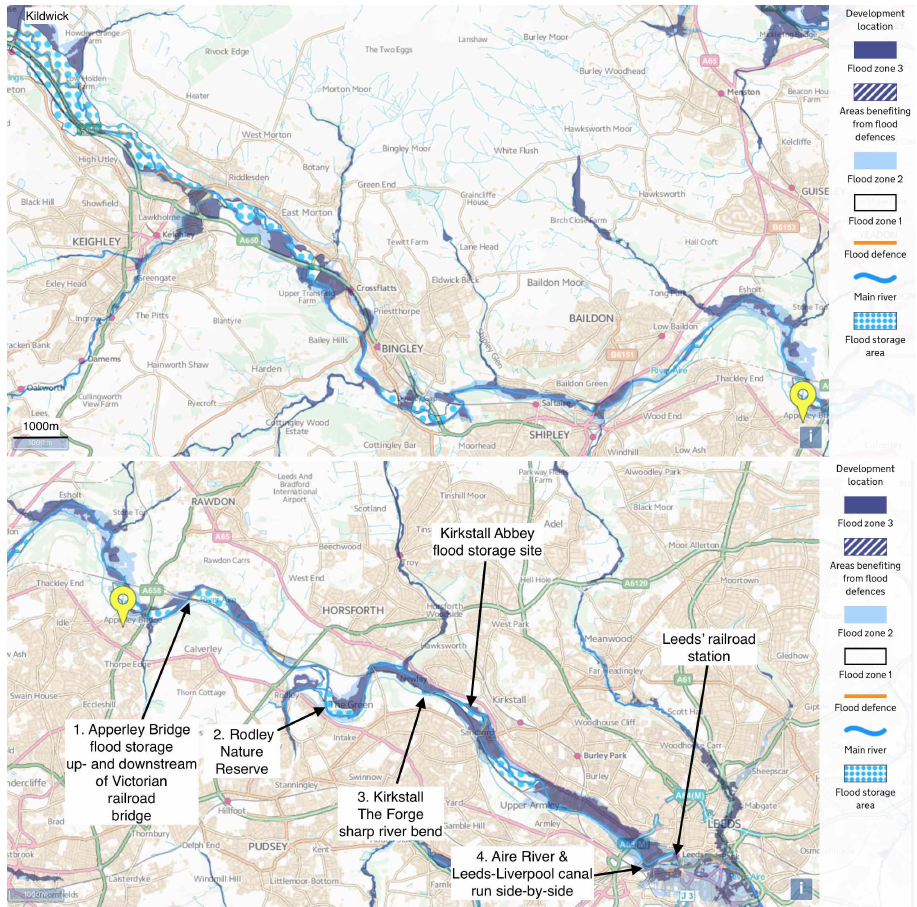
Figure 1. Environment Agency (EA) flood-risk maps of the sectors Kildwick (top left in upper map) to Apperley Bridge (yellow marker in both maps) and Apperley Bridge to Leeds (bottom right in lower map). Available online at https://flood-map-for-planning.service.gov.uk, for example, search (easting, northing) = (419,052, 437,681) for Apperley Bridge. Extra flood storage may be available at locations 1, 2, 3 and 4 on the lower map, respectively corresponding to the top-left, top-right, bottom-left and bottom-right photographs in Figure 11.